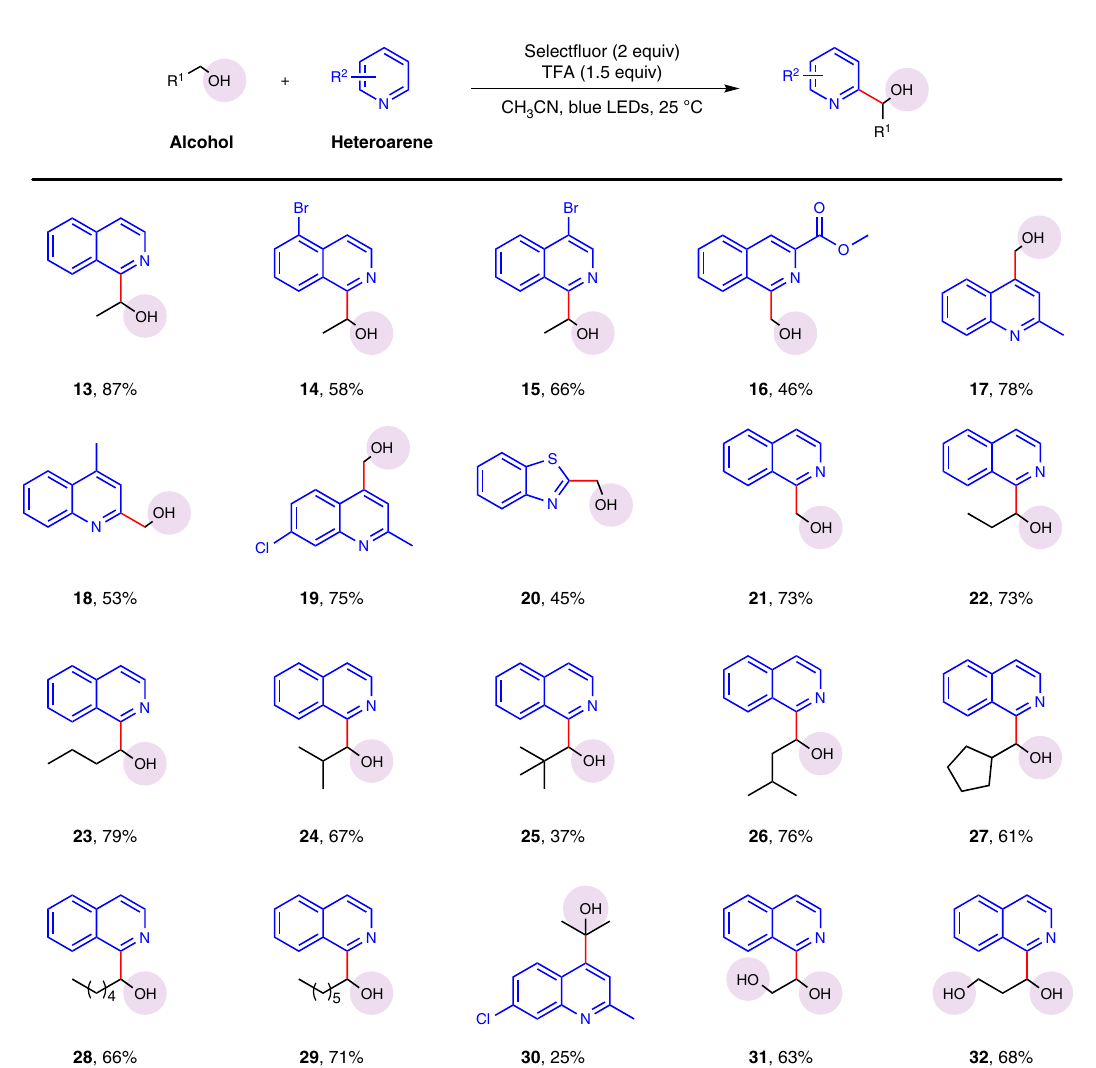
Fig. 5 Substrate scope for the α sp 3 C – H arylation of alcohols with heteroarenes. Reaction conditions: heteroarene (0.3mmol), alcohol (see Supplementary Methods for details), select fl uor (0.6mmol), TFA (0.45mmol), in CH 3 CN (2.0mL) (additional 0.75 mL DCE was added for 25 ) under a nitrogen atmosphere, irradiated with 3W blue LEDs at 25°C for